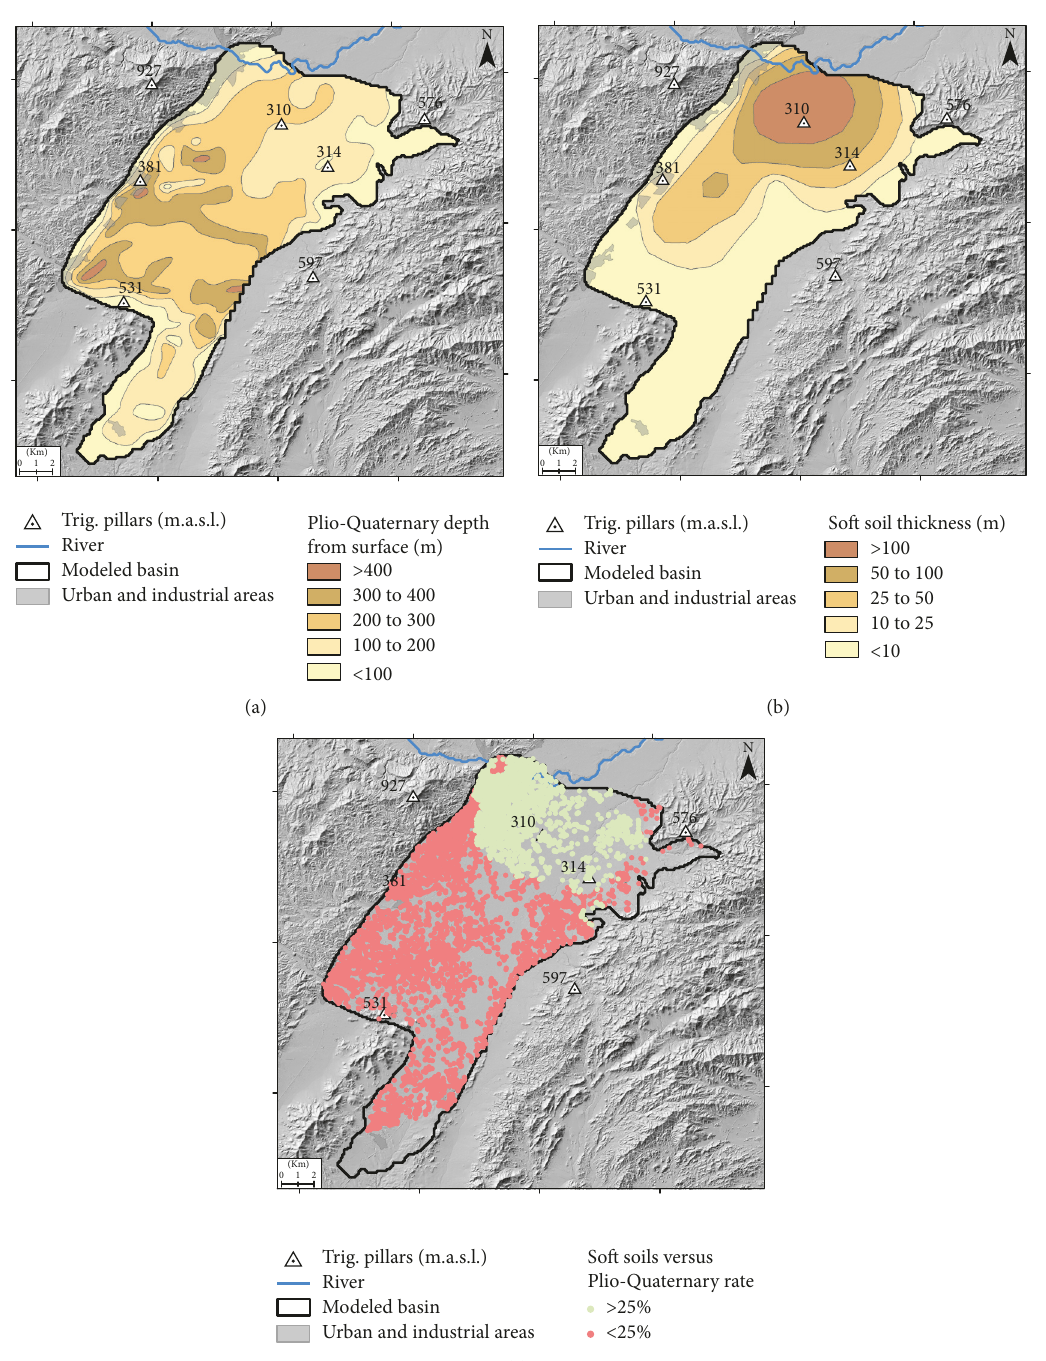
Figure 2: (a) Plio-quaternary materials depth, derived from Cer´on [22]. (b) Compressible soils thickness distribution from Bon´ı et al. [15]. (c) Populations of ENVISAT measurements considering the soft soil percentage (a) over the total thickness of Plio-Quaternary sediments